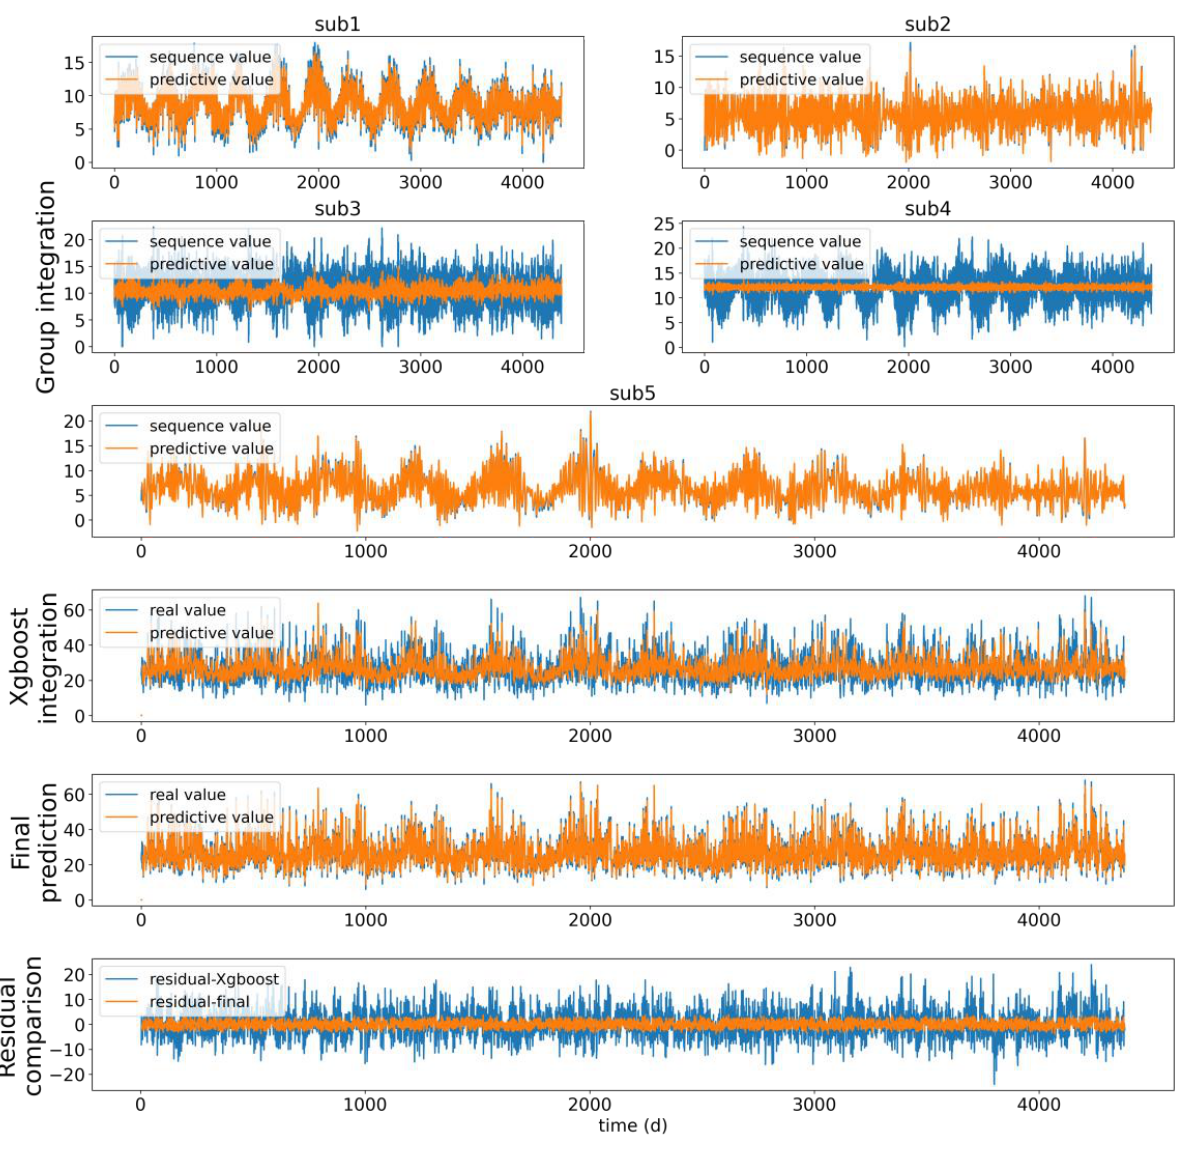
Figure 9. Box_Ljung value of each lag order. The integration process and the residual comparison are shown in Figure 10.